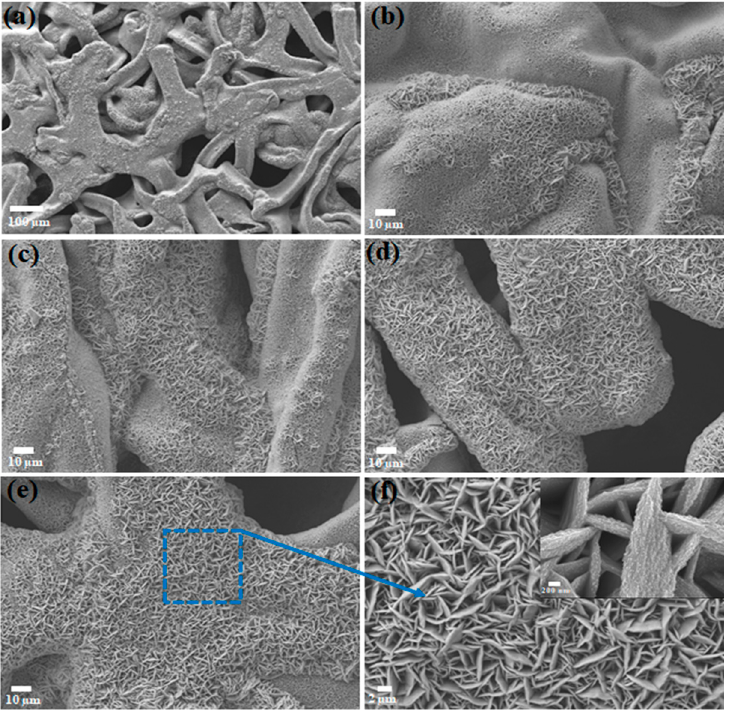
Figure 3. SEM images of Cu x S with different sulfur contents: ( a ) Cu x S-coated Cu foam; ( b ) 0.1 g of S; ( c ) 0.2 g of S; ( d ) 0.3 g of S; ( e , f ) 0.4 g of S with different magnifications.